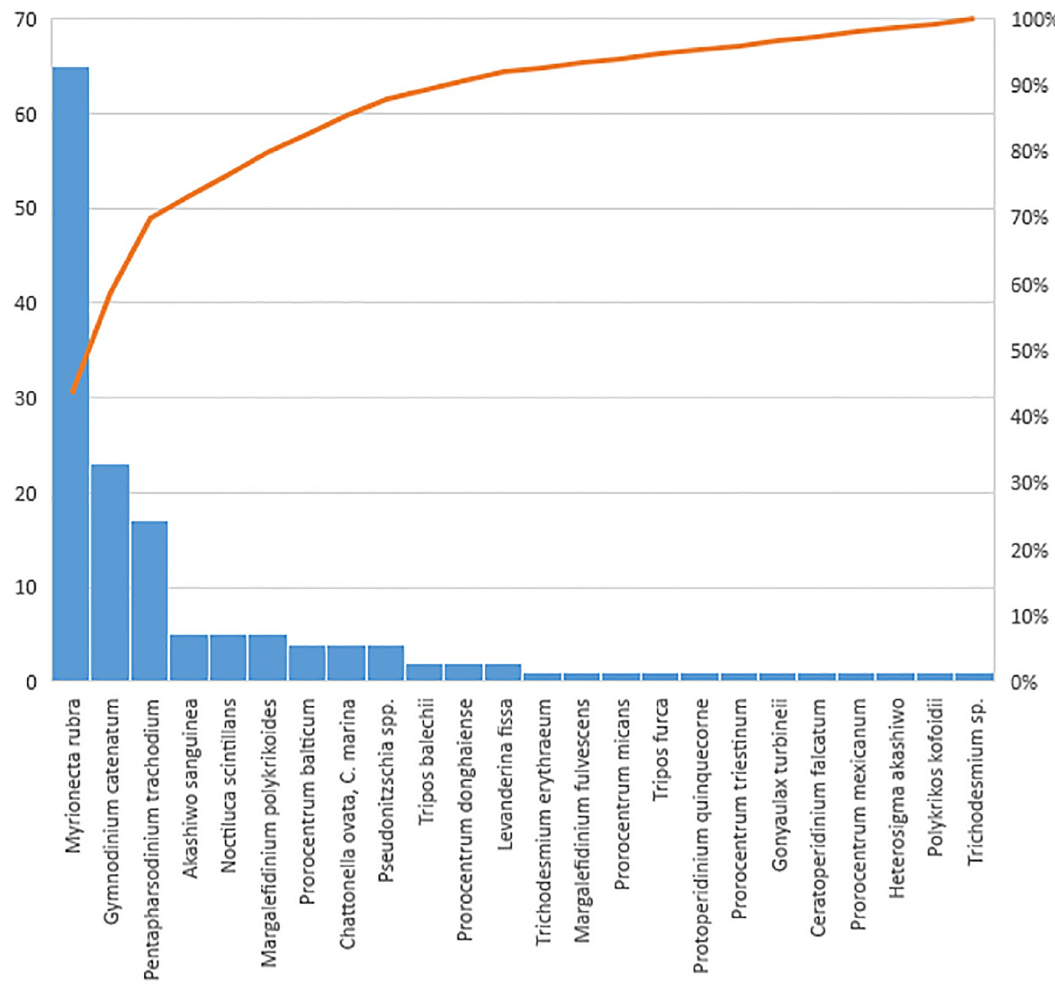
Fig 9. Pareto diagram of frequency of discoloration of forming species in Mazatlan